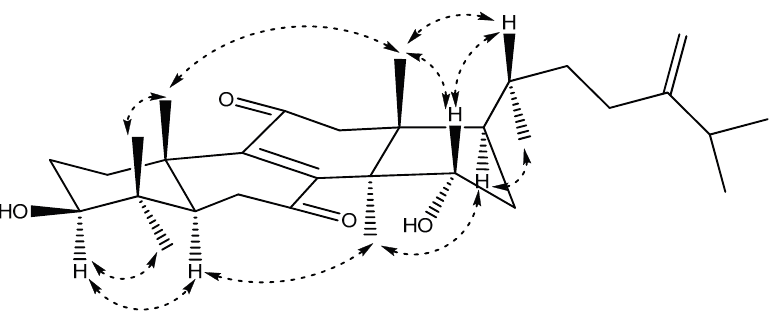
Figure 4. Key NOESY correlations of 2